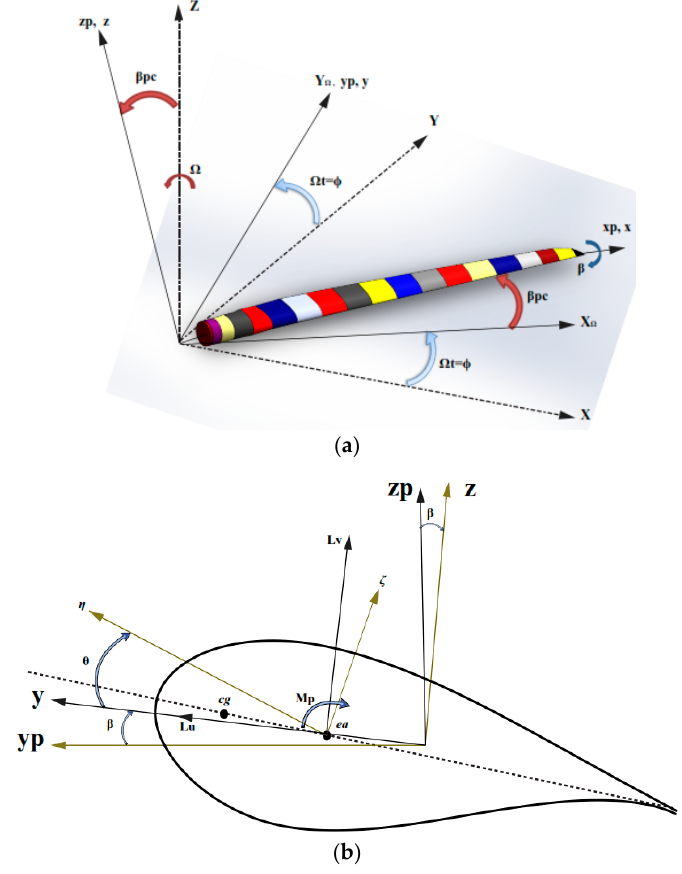
Figure 1. ( a ) Coordinate frames (3D); and ( b ) blade cross-section. Note: η and ζ : section coordinate, M p : pitching moment, θ : elastic twisting deflection, L u and L v : are the aerodynamic